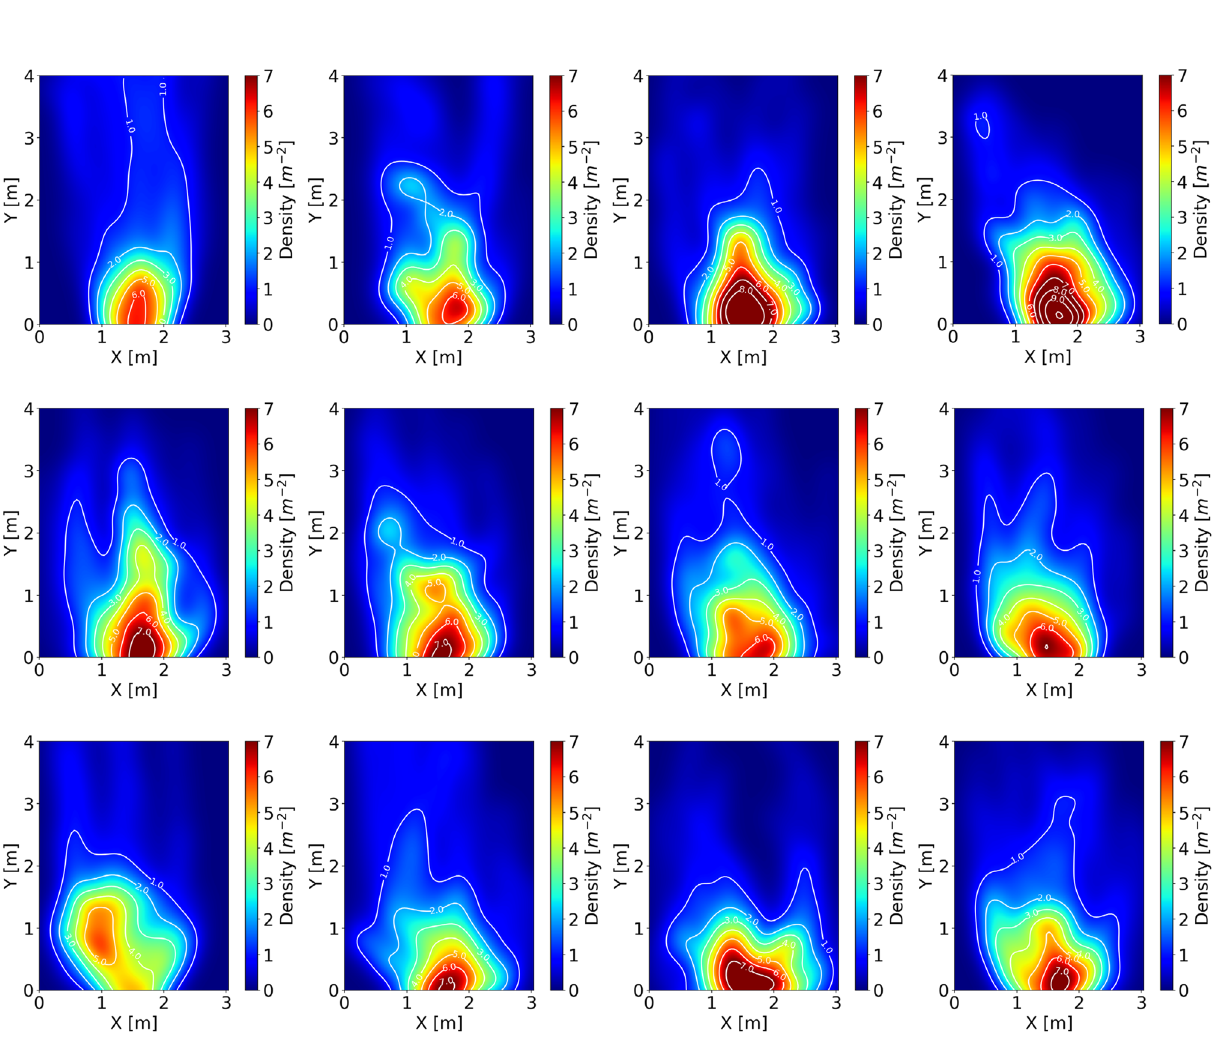
Figure 5. Density profiles during the congested stage in this study. Top row: r1, r2, r3, r4; middle row: r5, r6, r7, r8; bottom row: r9, r10, r11, r12. Color for the density value and white lines for density contours. Noted that in r9, the high-density region locates far from the exit, which is different from other experimental runs. Based on the experimental videos, the phenomenon is due to several children start playing in the region and fail to pass the exit quickly in this experimental